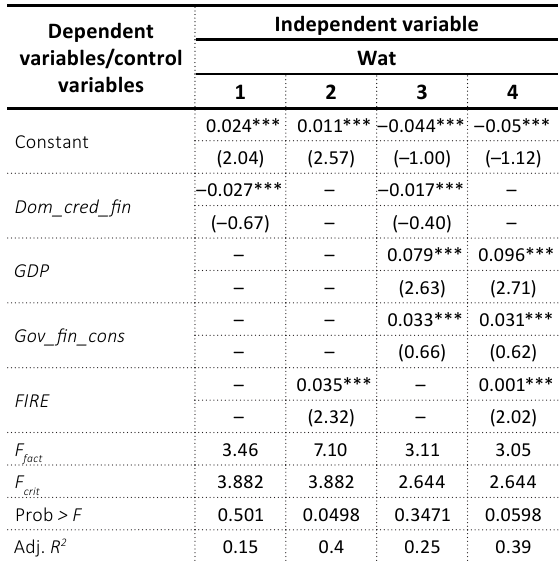
Table 4. Results of identifying the dependency between IMFR indicators and amount of infrastructure investment in water and